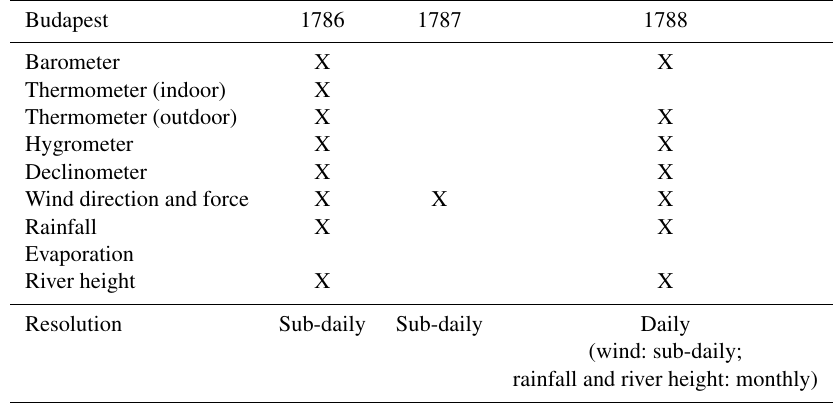
Table 2. Extract from the inventory for the station in Budapest for the years 1786–1788, showing how distinguishing between available parameter observations is both useful and